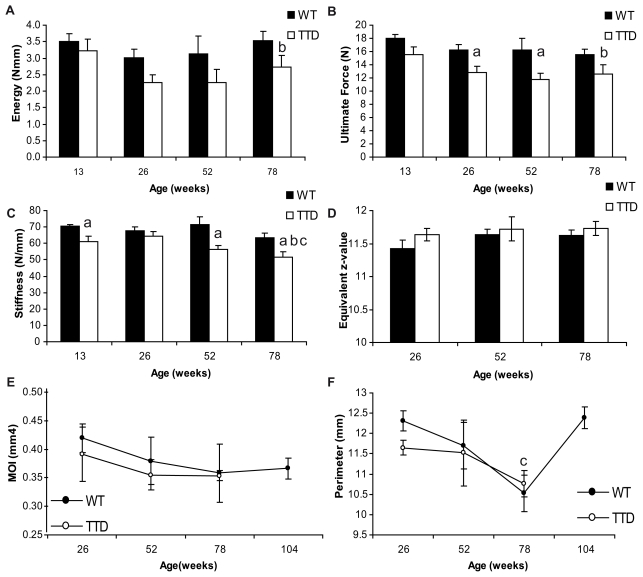
Decreased bone strength in TTD mice.Bone strength, mineralization, perimeter, MOI and bone formation rates in long bones of aging wild type (solid bars or symbols) and TTD males (open bars or symbols). (A) Energy to failure (B) Ultimate load (C) Bone stiffness, (D) bone mineralization, (C) MOI and (D) perimeter (Pm.). Statistics: a= student t-test; p<0.05 wild type vs. TTD, b−d = 2 way ANOVA; p<0.05. b= significant difference between wild type and TTD with aging, c= signifcant difference with aging within a genotype, d= a significant interaction between age and genotype. Error bars represent SEM.